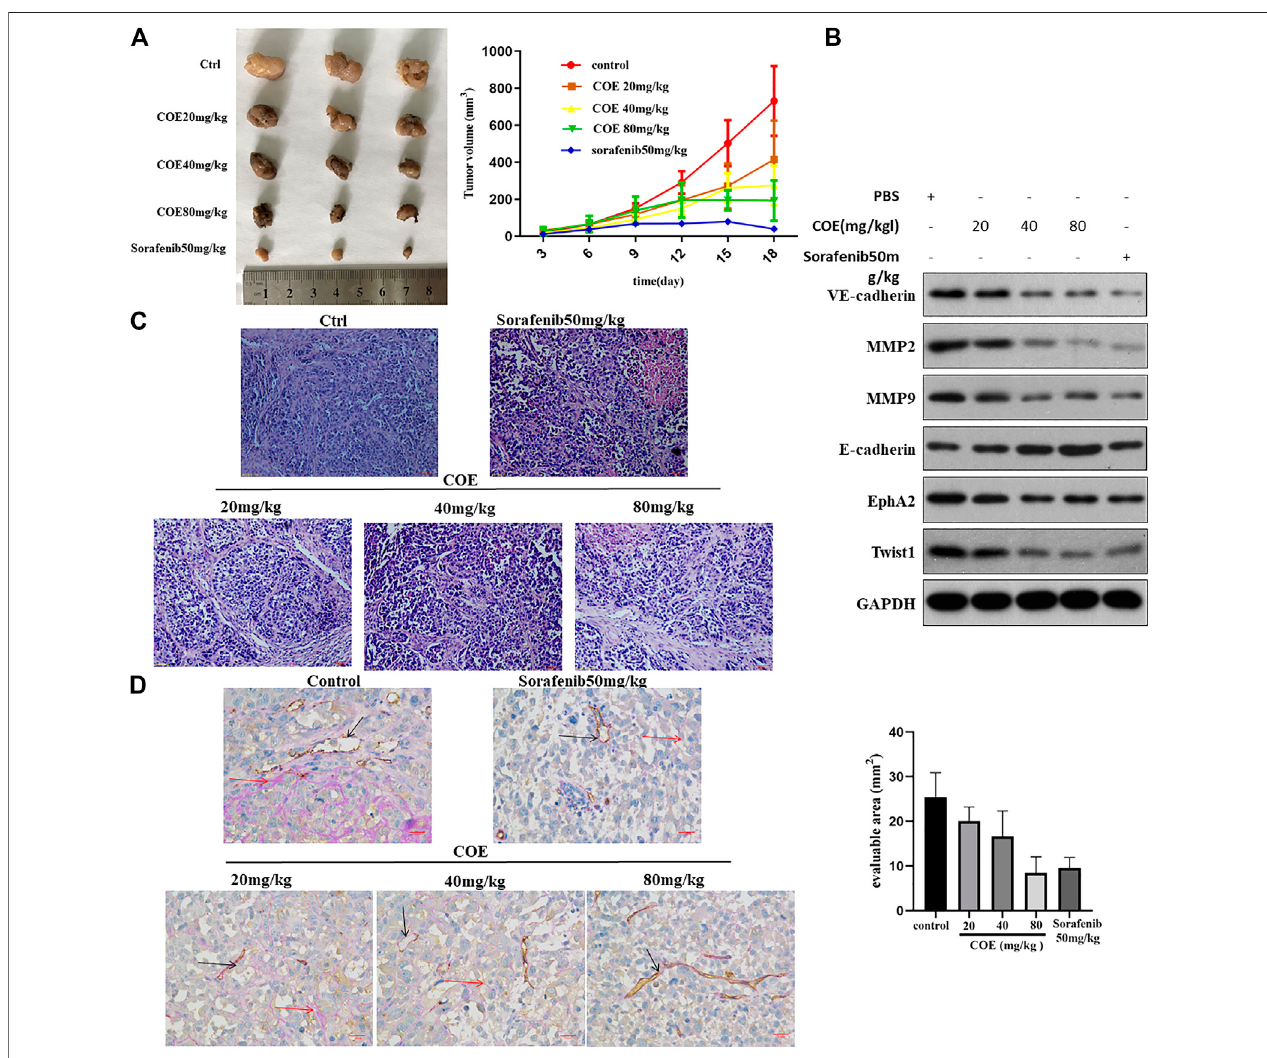
FIGURE7| COEinhibitsVMformationviainhibitingEphA2 invivo. (A) , leftpanel indicatestumor volumeineach group. Rightpanel ,thecurveindicates dynamic changes of tumor volume during the experiment. (B) , Western blotting on the expression of VM related proteins in tumor tissues. (C) , H&E staining on tumors in each group, × 400, 50 µm. (D) , left: CD31-PAS staining for VM in tumors. Right: the number of VM in evaluable area. × 400, 50 µm.